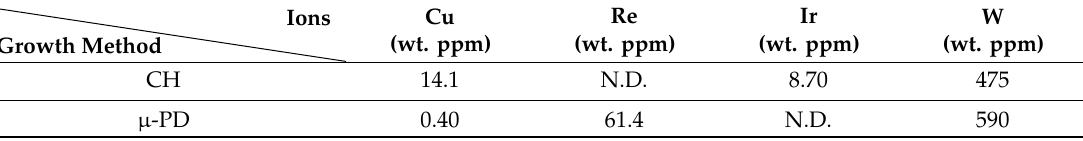
Table 1. ICP-MS results of the CH- and µ -PD-grown Yb1%-doped Lu 2 O 3 on Cu, Re, Ir, and W ions.